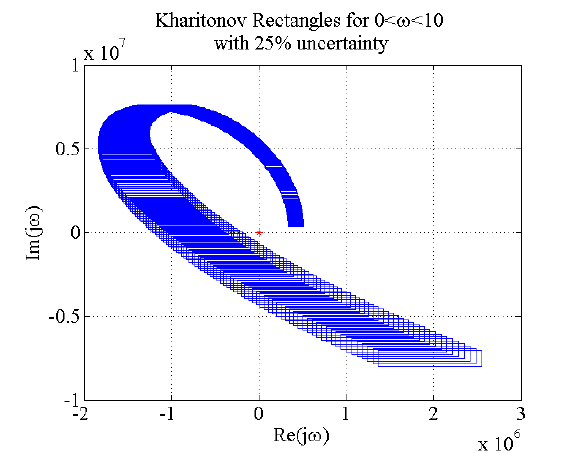
Figure 4. Kharitonov’s Rectangles and the zero exclusion principle. Star sign in red color indicates